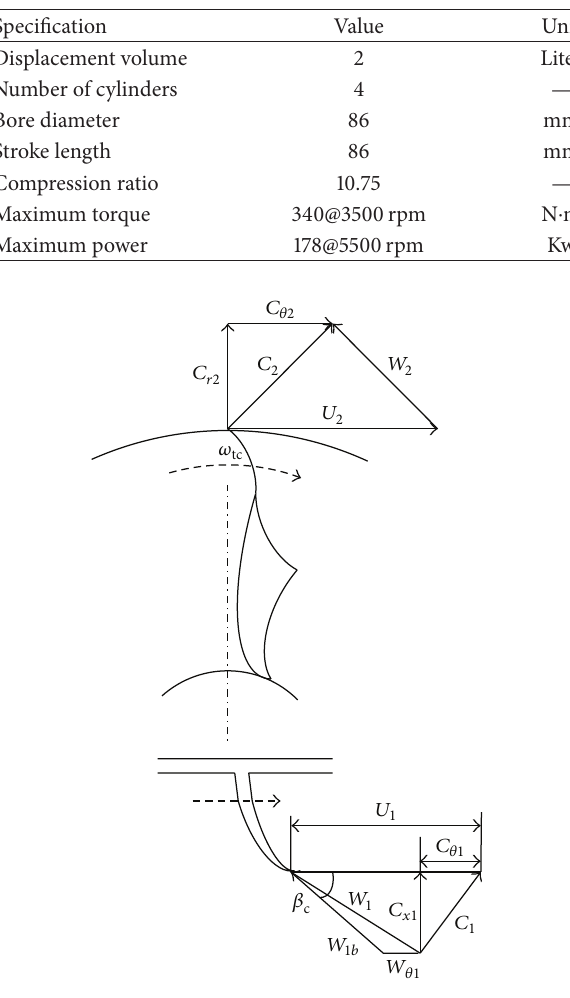
Figure 2: Velocity triangles of impeller eye and